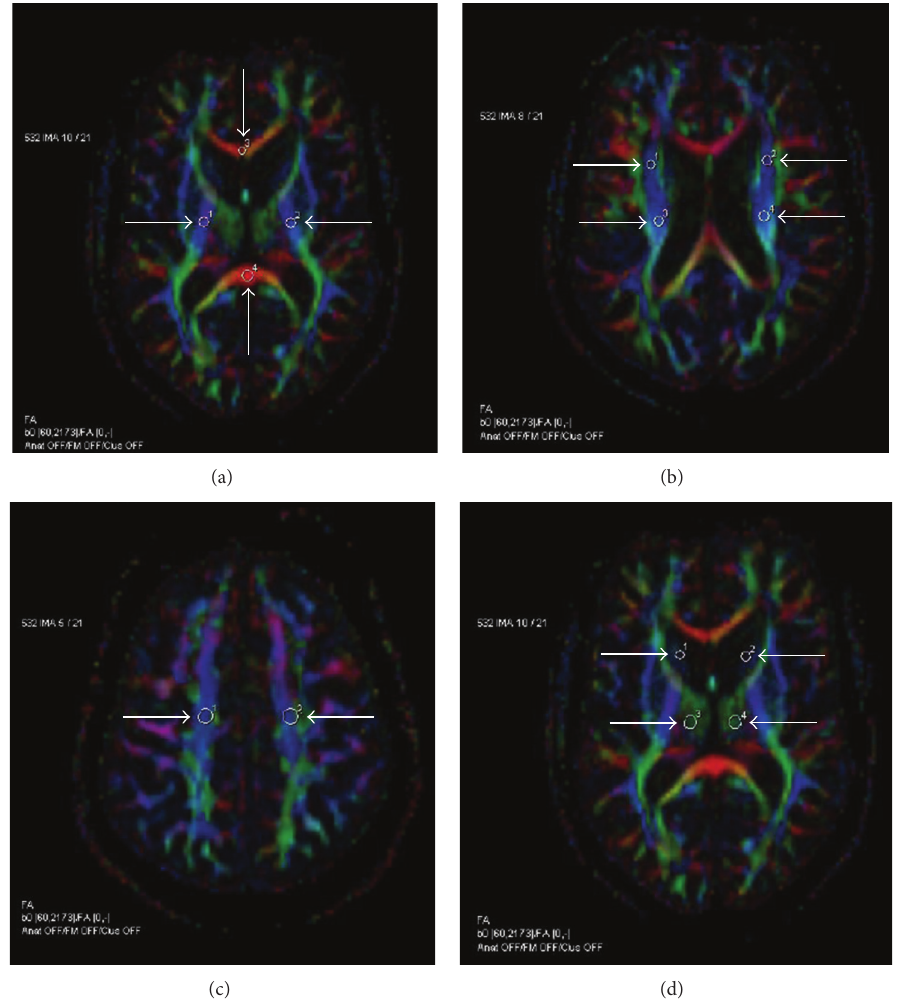
Figure 1: Region-of-interest (ROI) placement on axial FA colour maps. The posterior limb of the internal capsule (1, 2), the splenium (3), and the genu (4) of the corpus callosum (a); the posterior corona radiata anterior (1, 2) and posterior (3, 4) (b); the centrum semiovale anterior (c); and the caudate nucleus (1, 2) and the thalamus (3, 4) (d). Colours indicate the directions of fibre tracts ( red , transverse; blue , craniocaudal; green , anterior-posterior). The circular ROIs were transferred from the corresponding 𝐵 0 image, and their sizes have been adjusted to avoid any visible lesions. The size of the ROIs ranged from 2 to 33 pixels (6–106.5 mm 2 ; pixel size 1.8 ∗ 1.8 mm 2 ) depending on the size of the brain structure. This figure is a representative analysis from an SPMS